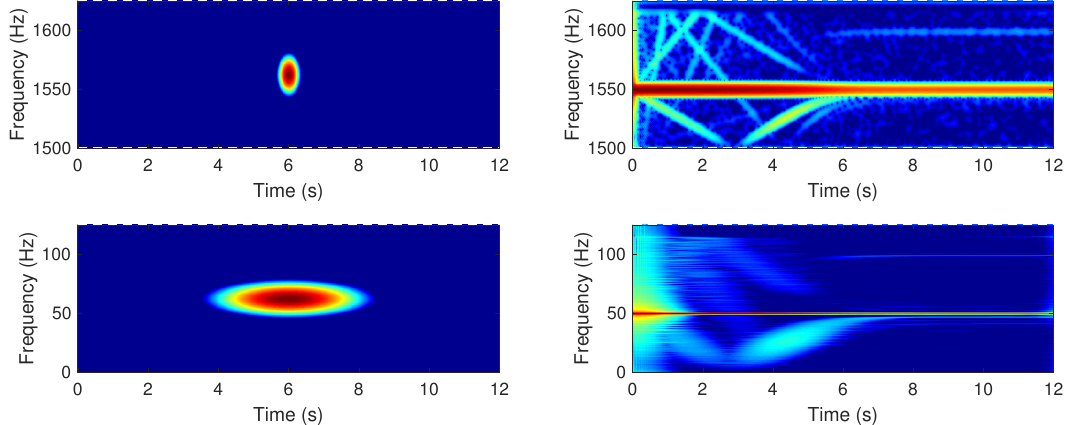
Figure 11. Zoom of Figure 10 showing two of the individual Gaussian windows contained in the multi-band window of Figure 10 ( left ) and the corresponding spectrograms generated with them ( right ). The two zoomed bands corresponds to the spectrogram located in base frequency band [0–125 Hz] ( bottom ), which defines clearly the fundamental component but blurs the fault harmonics and to the spectrogram shifted to the frequency band [1500–1625 Hz] ( top ), which defines clearly the fault harmonics but widens the fundamental